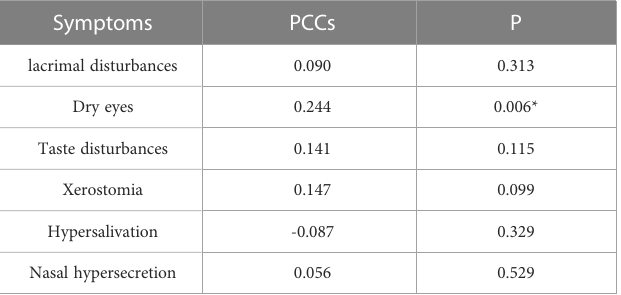
TABLE 5 Pearson correlation coef fi cient of postoperative HB grade and symptoms of NI injury.